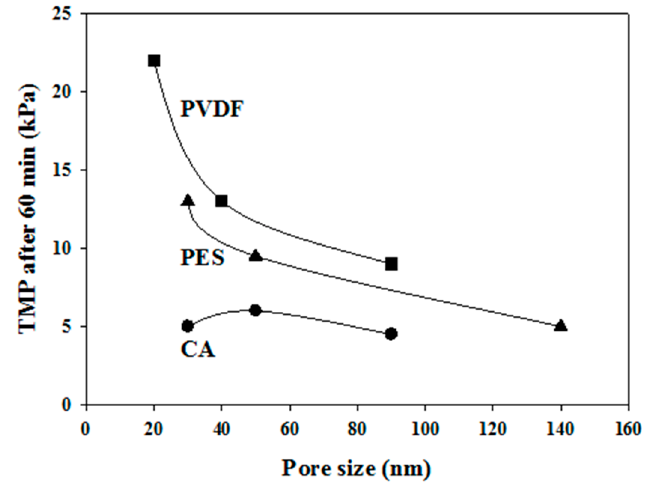
Figure 6. Relationship between membrane pore size and TMP for membranes using different polymer materials.